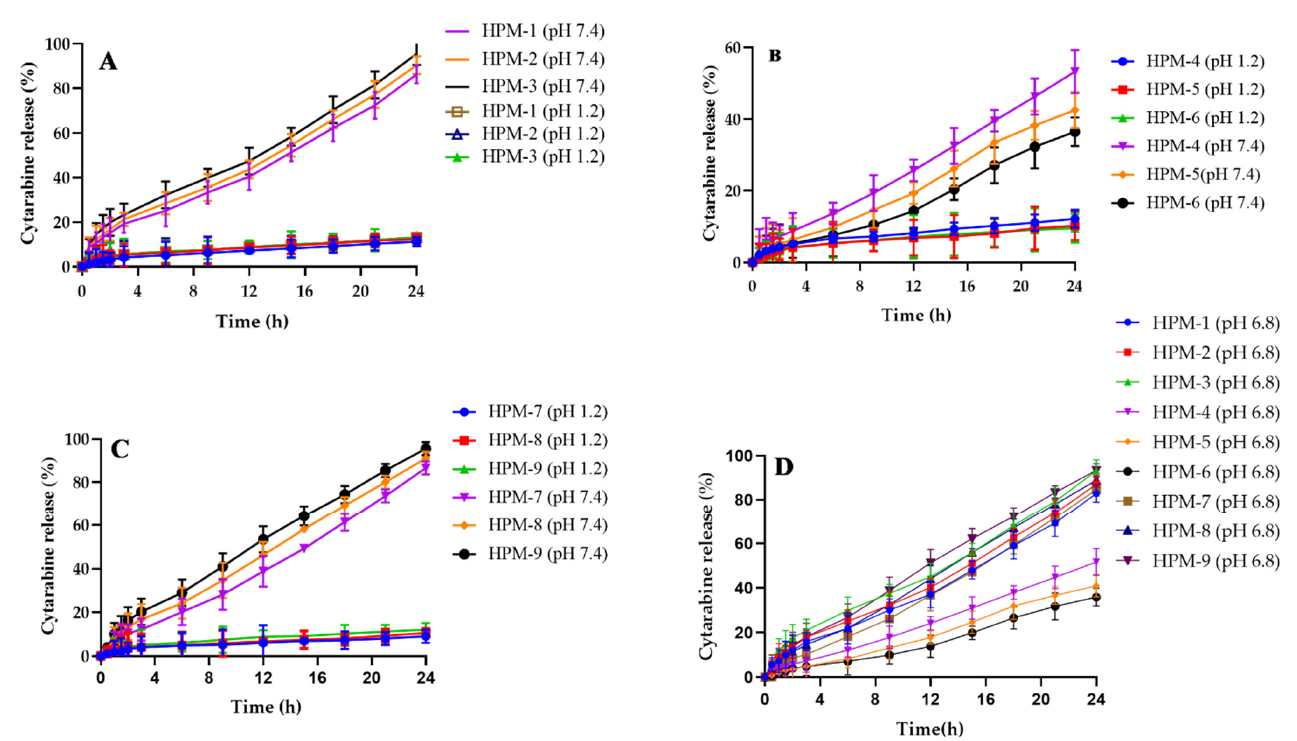
Figure 10. Cytarabine release studies at pH 1.2 and 7.4. Effect of HP β CD on cytarabine release ( A ), effect of MBA on cytarabine release ( B ), effect of MAA on cytarabine release ( C ) and cytarabine release at intestinal pH ( D ).